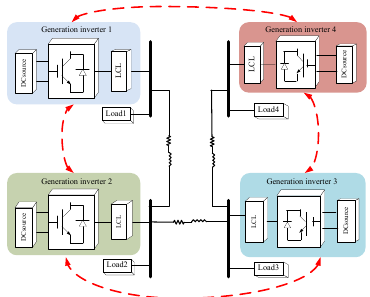
Figure 3. The test microgrid.